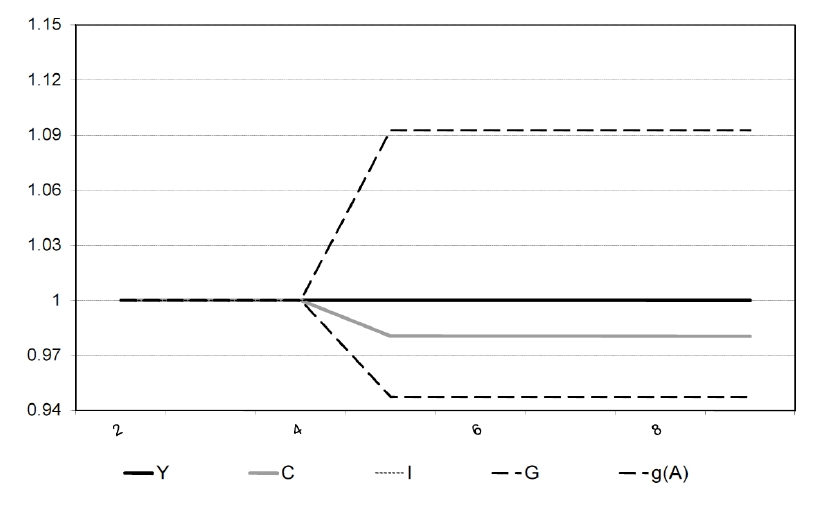
Figure 3. Effect of an increase in the carbon tax on the economy (Case